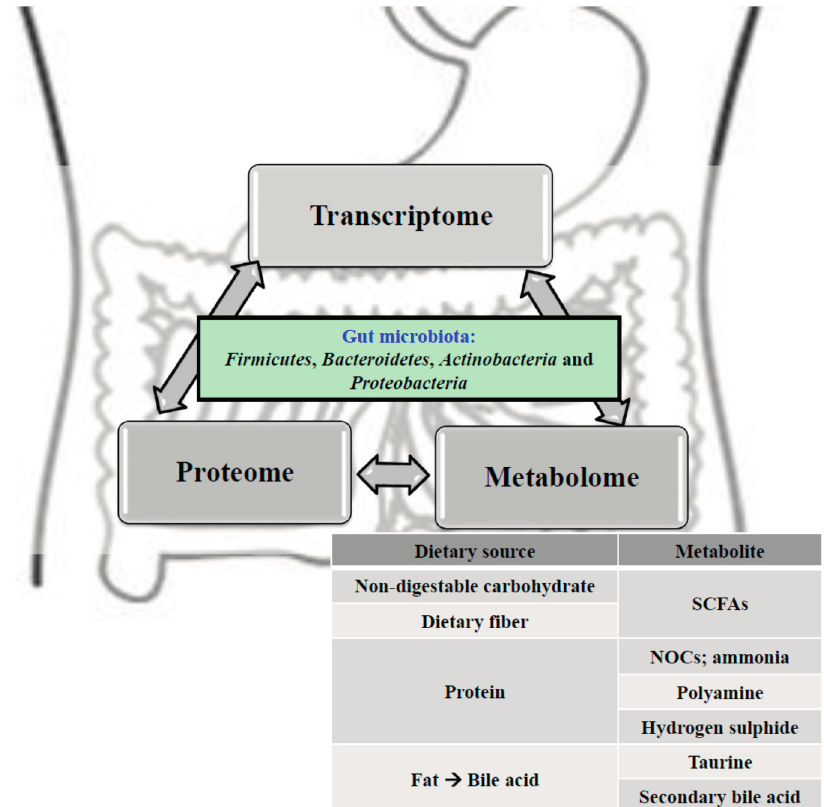
Figure 1. Our intricate gut ecosystem include four bacterial phyla: Firmicutes , Bacteroidetes , Actinobacteria , and Proteobacteria dominate the gut microbiota in mammals and these phyla have been reported to characterize the role of the host metabolism and physiology. Depending on the dietary lifestyle of the host, the gut microbiota and its metabolites such as N -nitroso compounds, ammonia, polyamine, taurine, bile acids, hydrogen sulphide, and short-chain fatty acids are highly implicated in the etiopathogenesis of metabolic diseases, intestinal diseases, and extraintestinal diseases, thereby playing a vital role in host